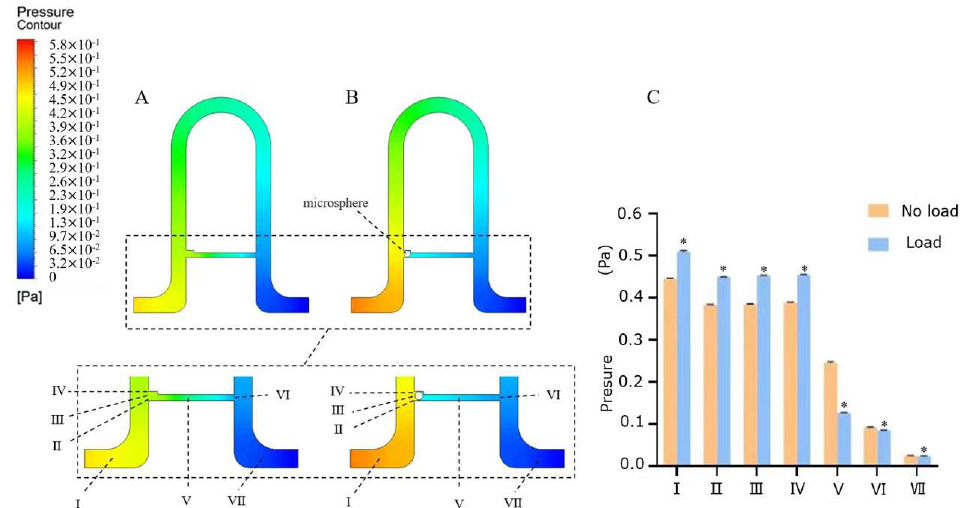
Figure 3. Simulated pressure characteristics of the trapping cavities and main channel. ( A ) Pressure contour of empty capture area and bypass channel at the flow velocity of 0.0026 m/s. ( B ) Pressure contour of Channel with a trapped microbead. ( C ) Calculated pressure variation for channel A and Channel B, * indicates significant difference P values ≤ 0.05.